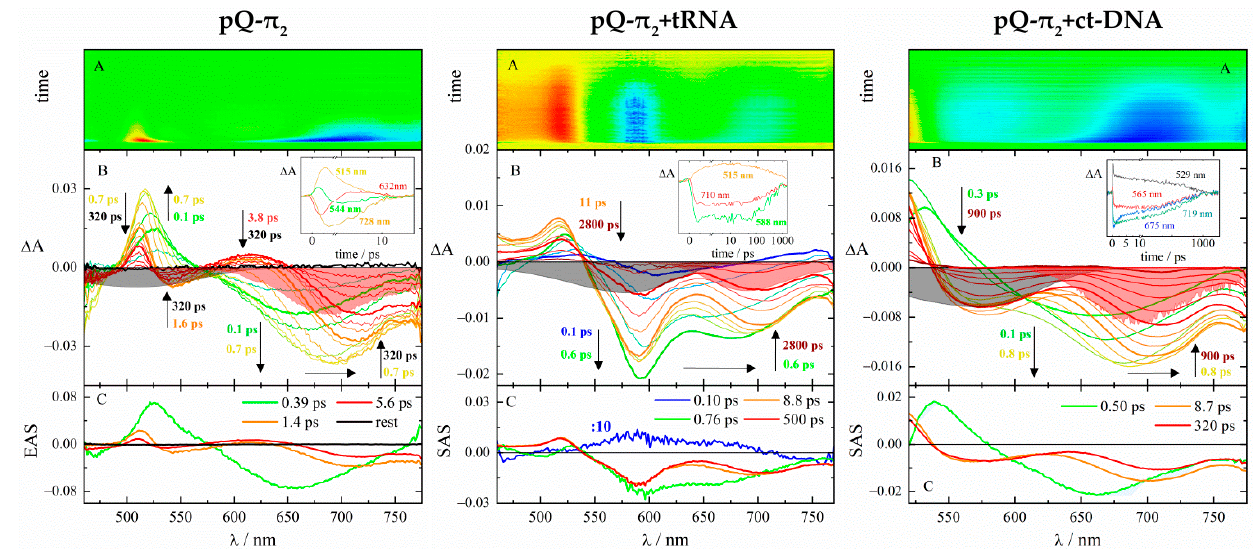
Figure 5. Femtosecond transient absorption (fs-TA) measurements of compound pQ- π 2 in ETN buffer solution, pH 7.4, alone ( left ) and in the presence of tRNA ( middle ) and ct-DNA ( right ), with r ([compound]/[nucleic acid]) = 0.02, obtained by pump-probe experiment ( λ exc = 400 nm): panel A , experimental 3D matrix reporting color-coded ∆ A as a function of wavelength and time ( ∆ A > 0 yellow-orange, ∆ A < 0 blue); panel B , representative spectra at different delay times and representative kinetics (inset) at different wavelengths, together with steady-state absorption (gray-shaded area) and fluorescence (red-shaded area); panel C , EAS (evolution-associated spectra) obtained by Target Analysis. Table 4. Fs-TA results of compounds pPy- π 2 and pQ- π 2 in ETN buffer solution, pH 7.4, alone and in the presence of tRNA and ct-DNA, obtained by Global Analysis or Target Analysis.